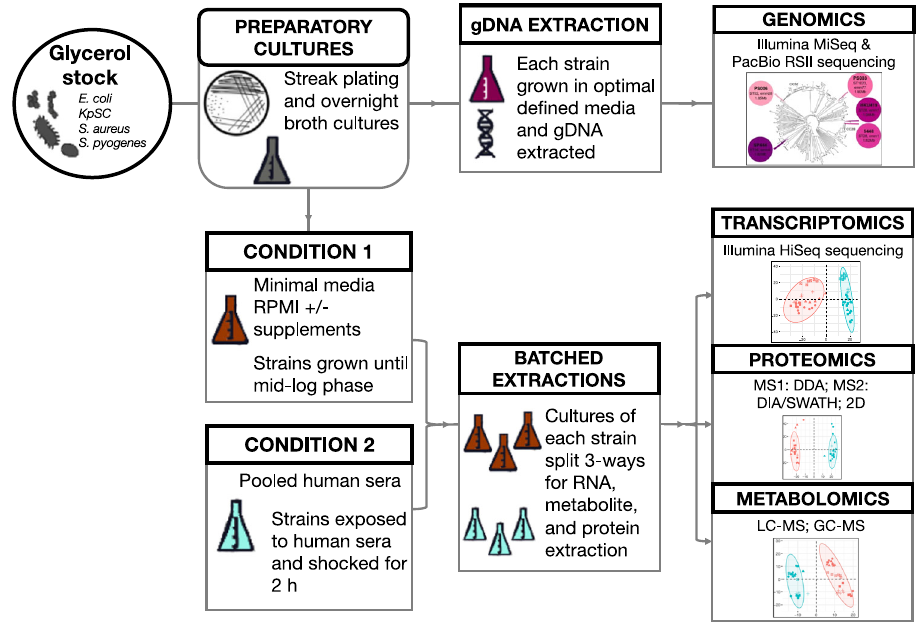
Fig. 1 | Schematic of the experimental work fl ow employed in this study. A sample of gDNA extracted from each strain of each species was split in order to prepare parallel sequencing libraries for both long-read (PacBio RSII) and short- read (Illumina MiSeq) sequencing. Biological replicates for transcriptomics,